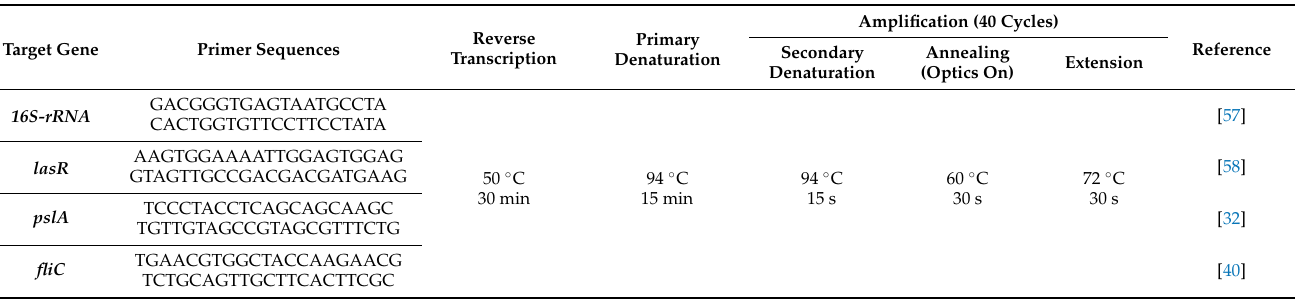
Table 3. Primers and RT-PCR thermal